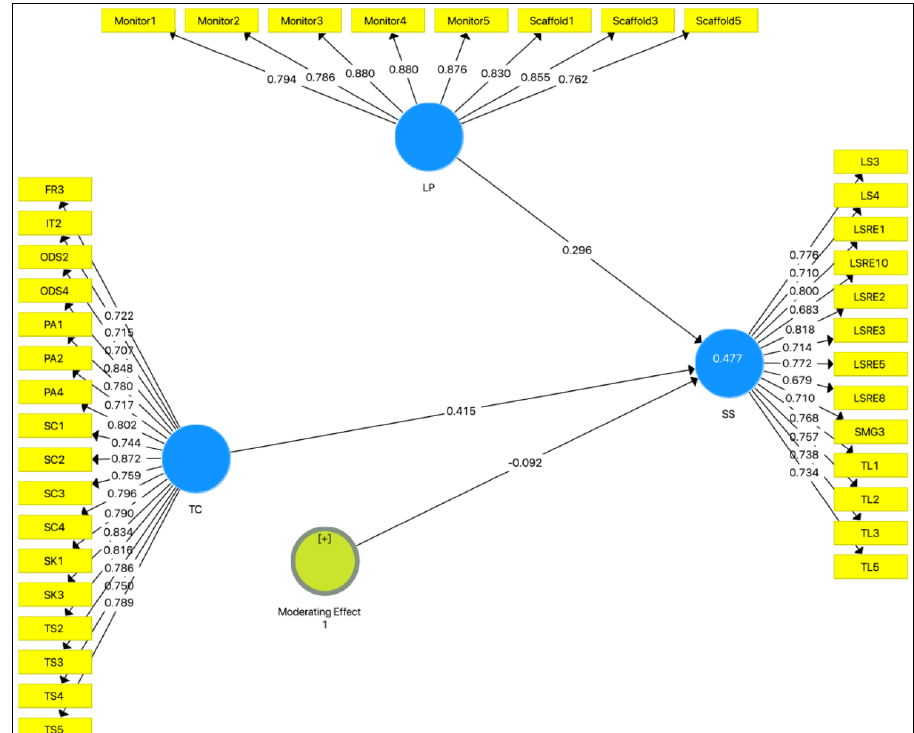
Figure.2. Structural Equation